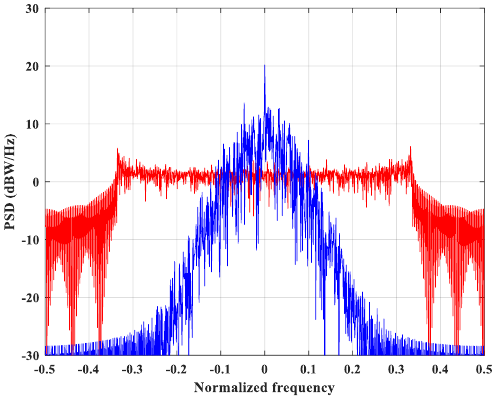
Figure 8. PSD for PM-OFDM-CDMA compared to OFDM-CDMA (2πh=1.2).